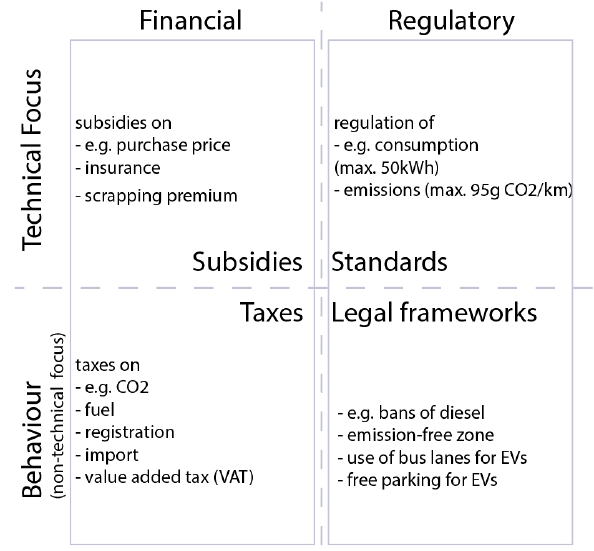
Figure 3. The four major dimensions of energy policies with a special focus on transport.